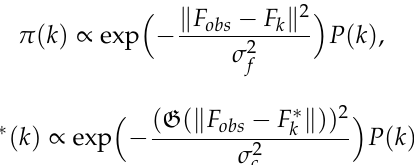
Algorithm (Two-stage MCMC [32]) : Suppose at the nth step, we have α n , θ n , and permeability field k n